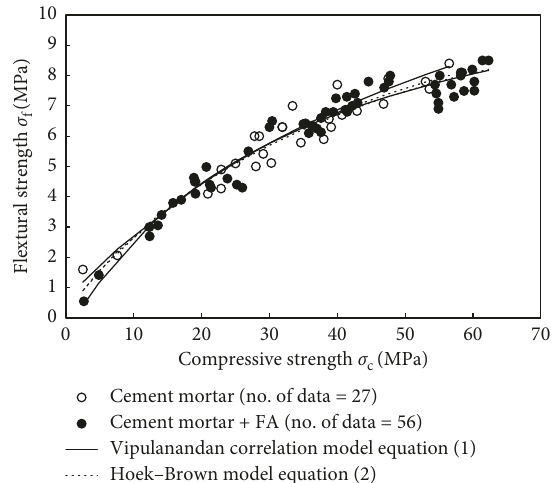
Figure 13: Variation of flexural and compressive strengths of cement mortar with and without fly ash